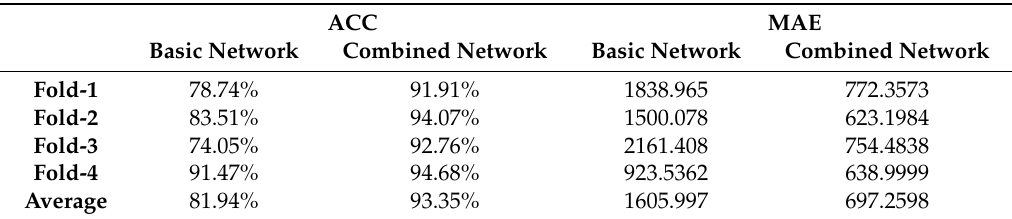
Figure 9. Segmentation map ( B ) predicted by the Segmentation Network on a cropped UAV image ( A ) and the corresponding binary map ( C ) calculated by Equation (1). The threshold range is fixed at [90, 265]. Table 2. Comparing the performance of the Basic Network and Combined Network for counting rice seedlings in the RSC